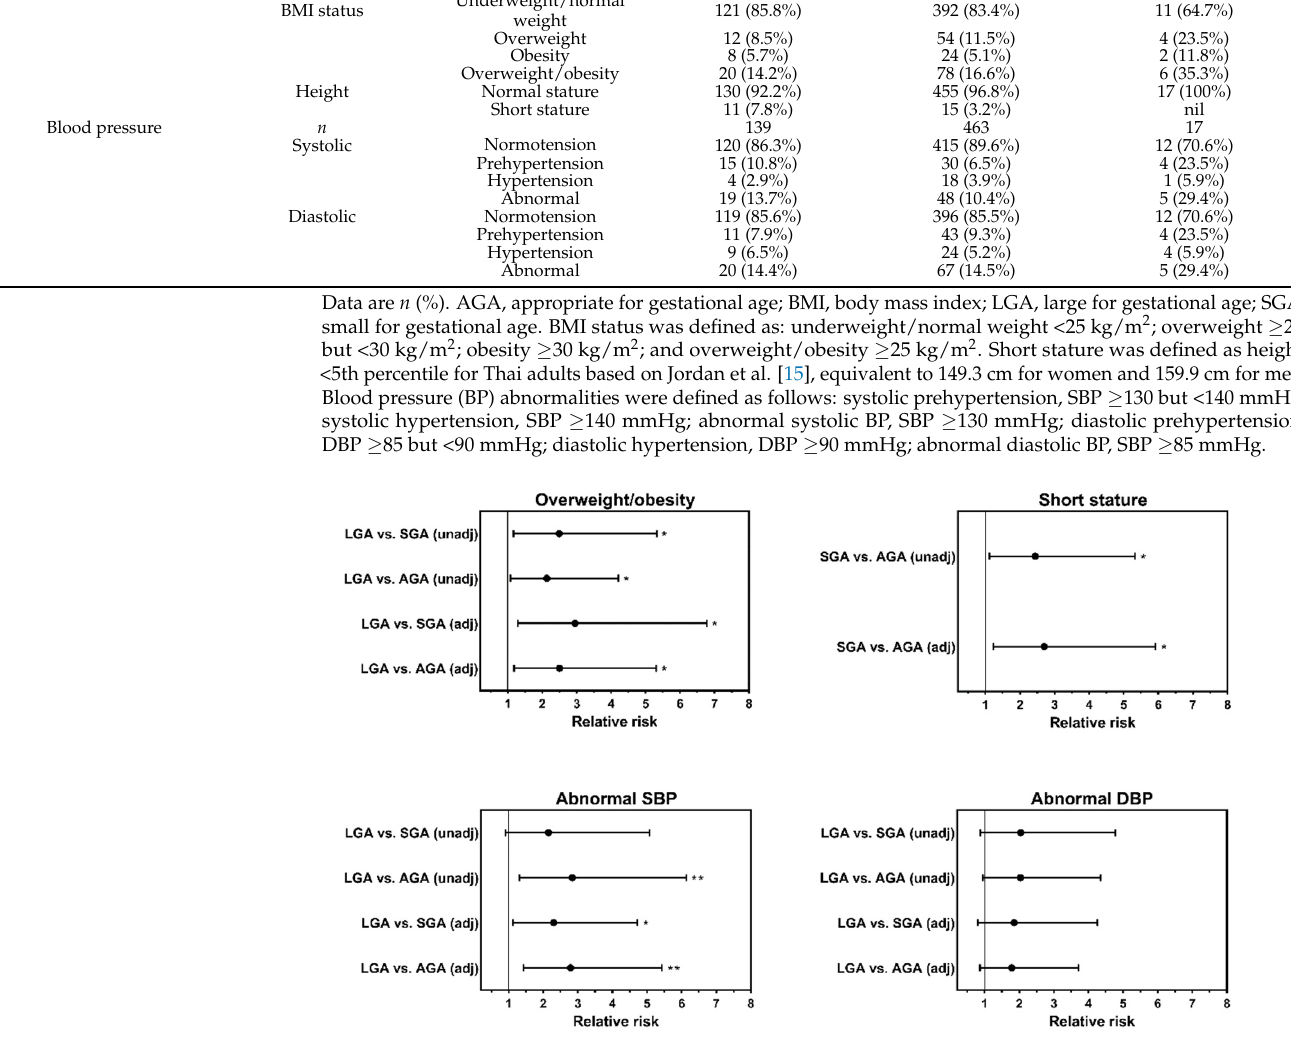
Figure 2. Adjusted relative risks of adverse anthropometric and blood pressure outcomes among young adults in Thailand according to their birth weight status. Data are relative risks or adjusted relative risks and respective 95% confidence intervals; * p < 0.05 and ** p < 0.01 for the difference between two given groups. AGA, appropriate-for-gestational-age; DBP, diastolic blood pressure; LGA, large for gestational age; SBP, systolic blood pressure; and SGA, small for gestational age. Overweight/obesity was defined as a body mass index ≥ 25 kg/m 2 ; short stature was defined as height <5th percentile for Thai adults based on Jordan et al. [15], equivalent to 149.3 cm for women and 159 . 9 cm for men; abnormal SBP was defined as ≥ 130 mmHg and abnormal DBP as ≥ 85 mmHg .